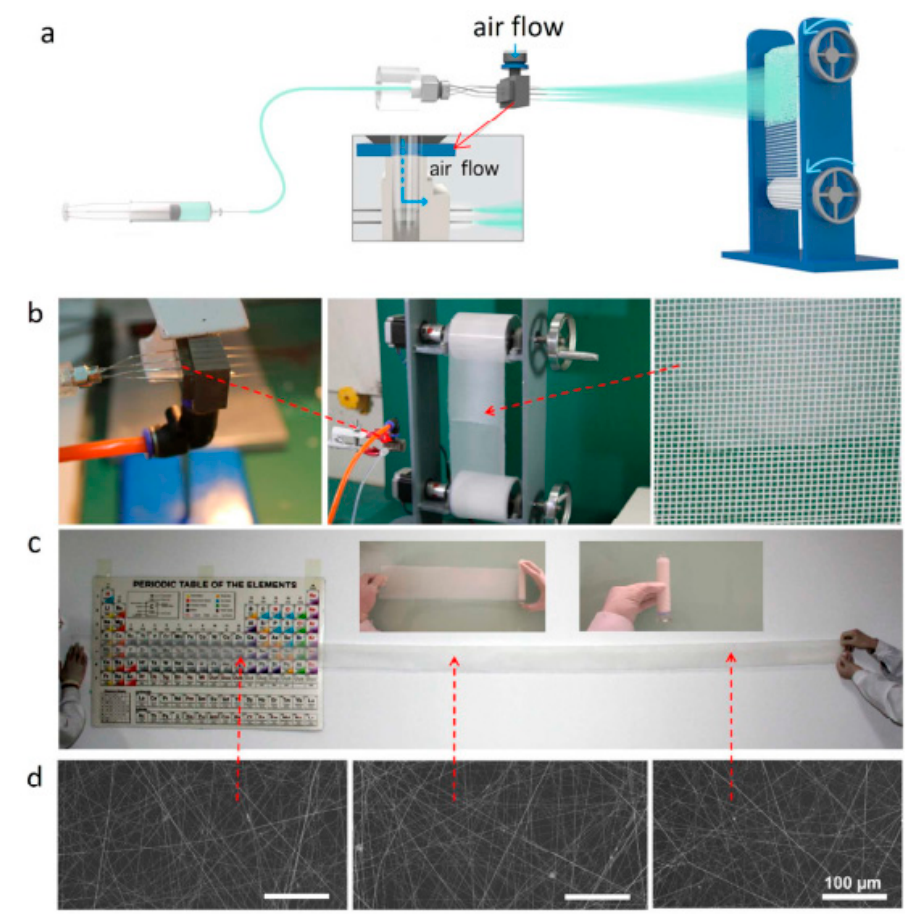
Figure 12. Roll-to-roll production of nanofibers. ( a , b ) Experimental setup; ( c ) A transparency check of deposited fibers; ( d ) SEM images of the blowspuns taken from three different places of the coated rolling mesh.